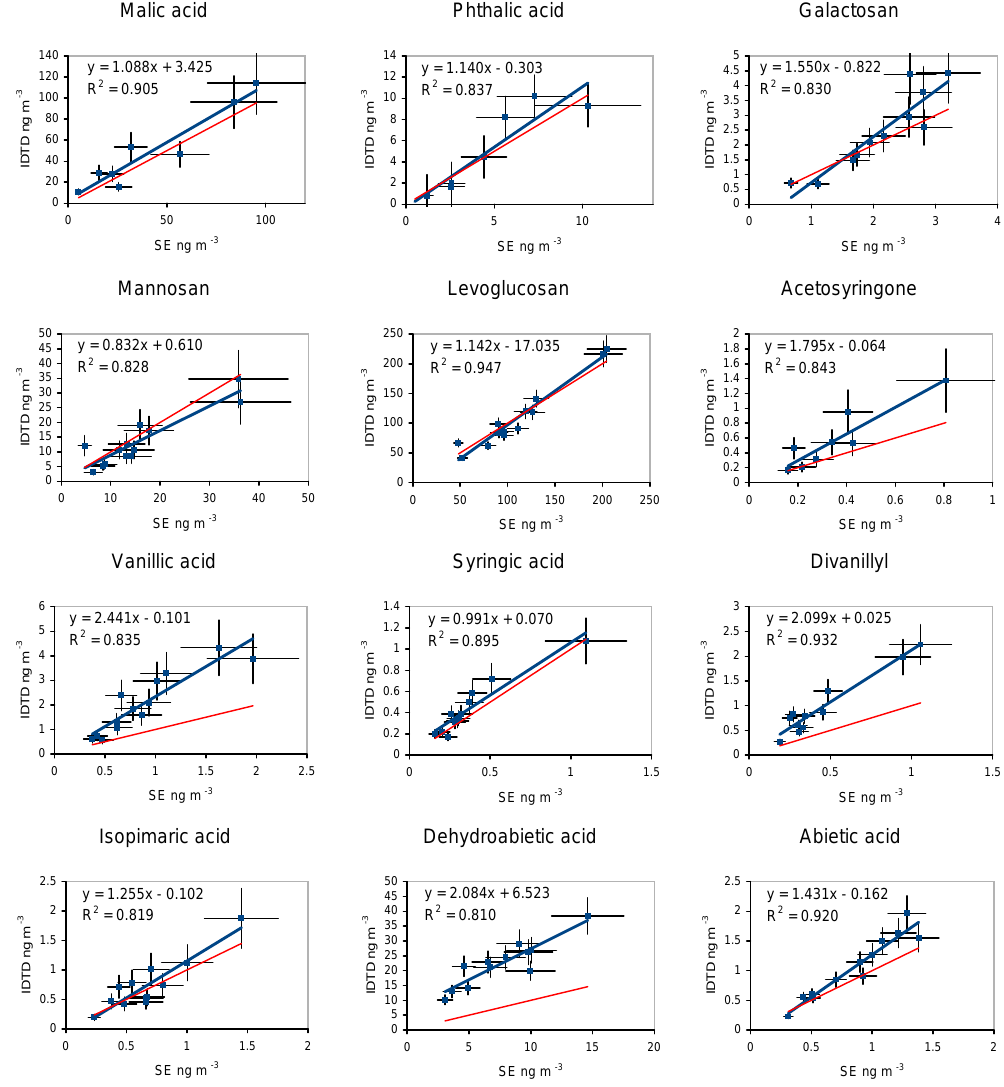
Fig. 5c. Correlation of IDTD and SE for analysis of polar substances in ambient aerosol samples (blue: linear regression, red: line through origin, slope